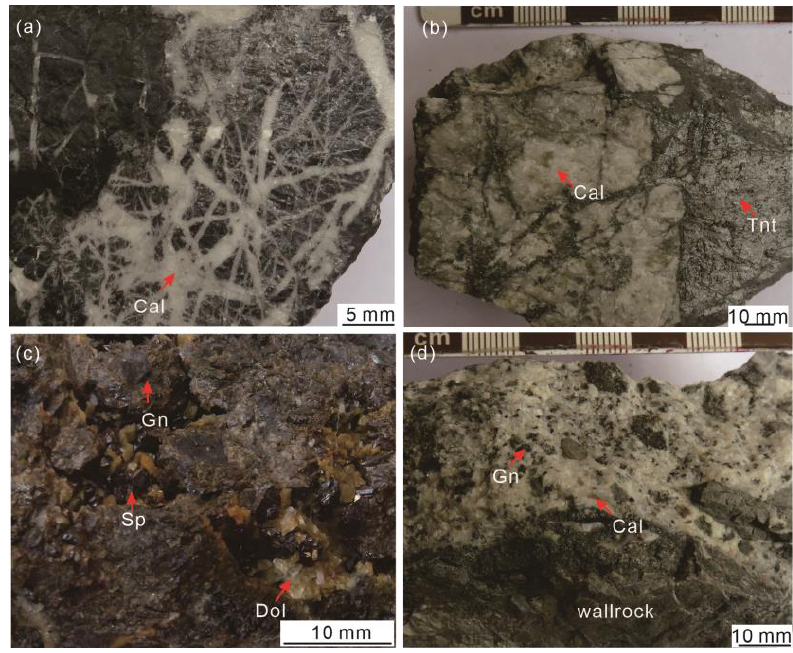
Figure 2. Macroscopic features of ore samples: ( a ) warly calcite vein; ( b ) tennantite cementing brecciated carbonate (Cu – Co stage); ( c ) sphalerite – galena – dolomite mineral paragenesis (Pb – Zn stage); and ( d ) galena – calcite vein within the wall rock (Pb – Zn stage). Abbreviations: Cal = calcite, Dol = dolomite, Gn = galena, Tnt = tennantite, and Sp = sphalerite.